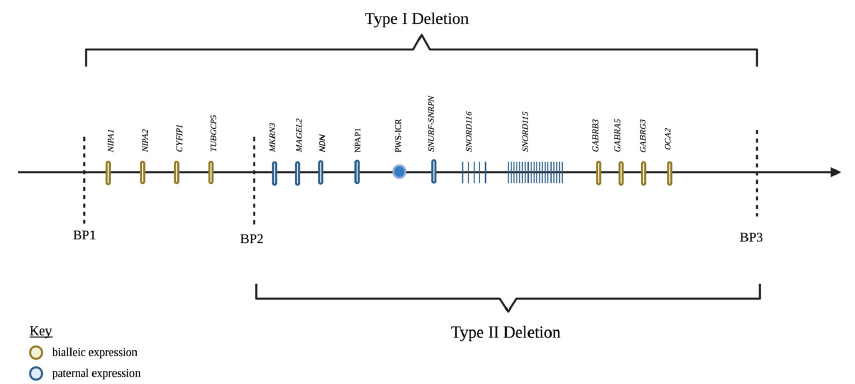
Figure 1. Genes in the PWS critical region, chromosome 15q11.2-q13. Created with BioRender.com (accessed on 25 March 2022).